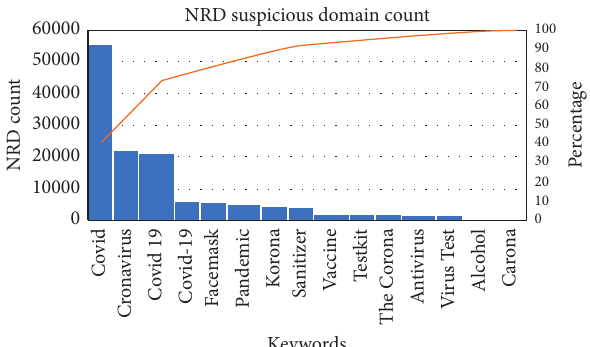
Figure 21: Daily report on newly suspicious